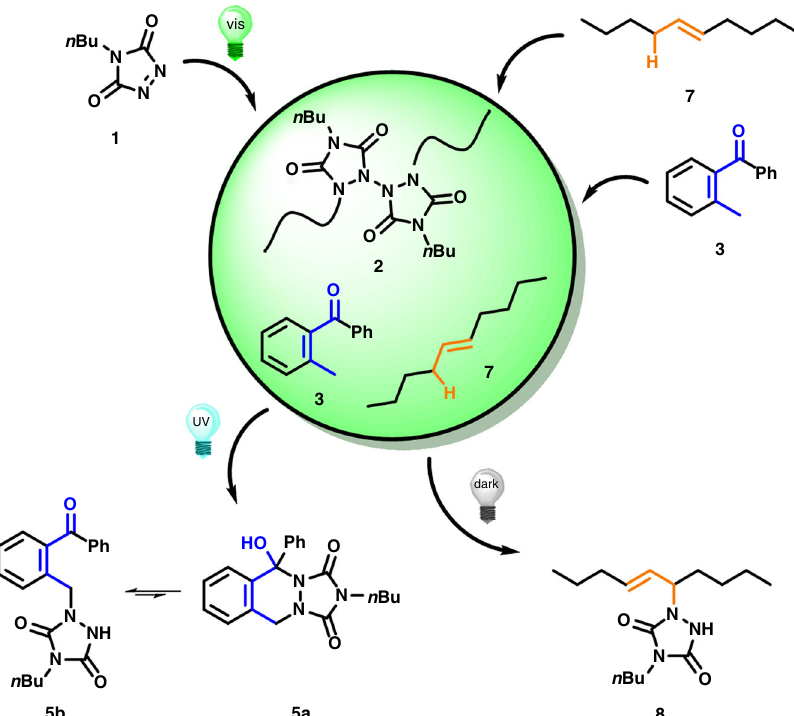
Fig. 5 Light-switchable TAD reaction manifold. After the visible light-induced deactivation of 1 , aliquots of o -methylbenzophenone 3 and trans -5-decene 7 (1:1 eq.) were added to give a non-reactive mixture ( 2 + 3 + 7 , 0.15 M, CDCl 3 ) whilst the visible light is kept switched on. Subsequently, UV light acts as a gate to selectively switch the reaction outcome between photoenol products 5a+5b and the thermal TAD addition product